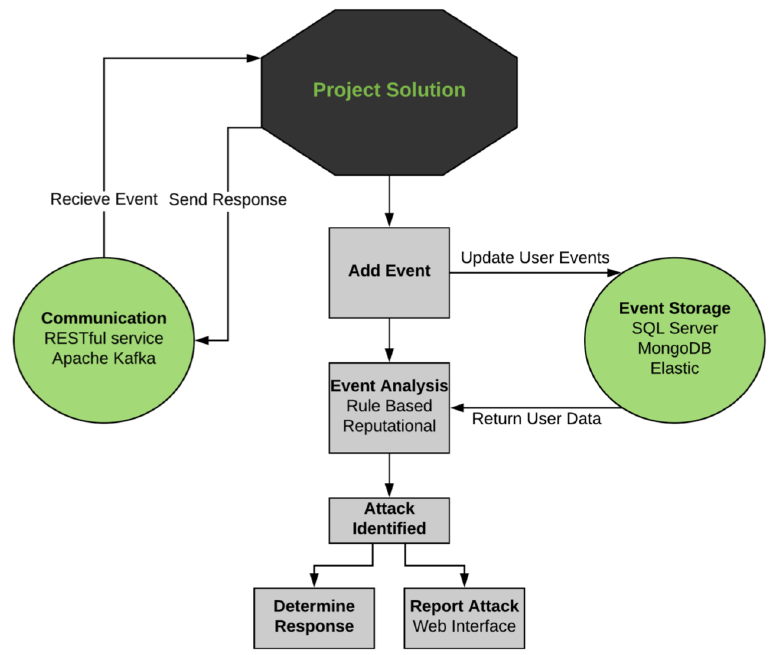
Figure 5. BlackWatch system